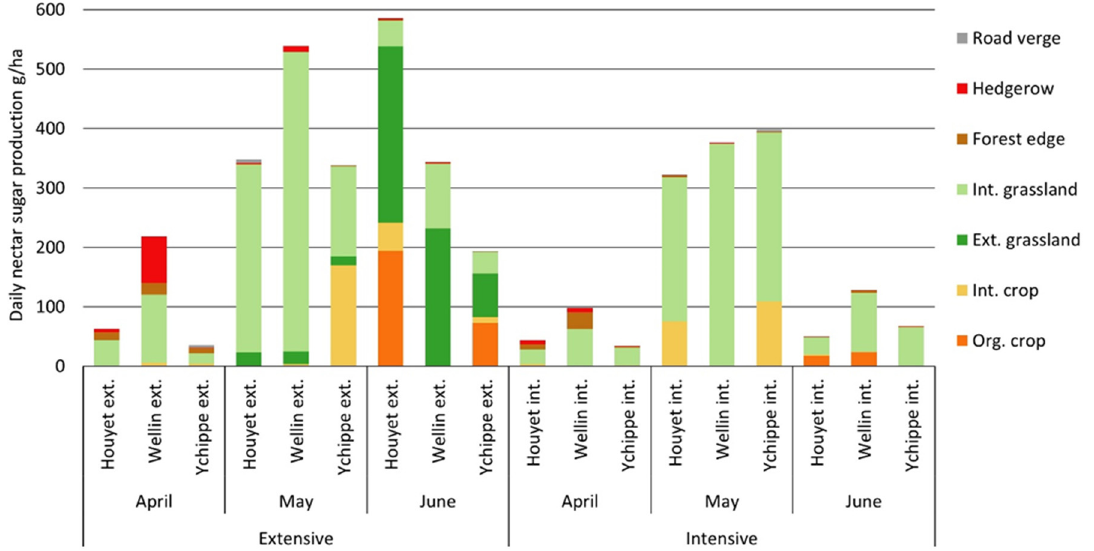
Figure 2. Daily nectar sugar production (g ha − 1 day − 1 ) at the landscape scale for each month. Each bar represents the sugar-production contribution of a given landscape element for one average hectare of the landscape. Ext., extensive, int., intensive, org., organic.